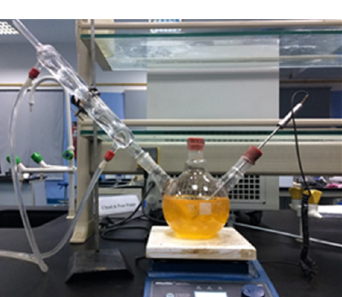
Figure 3. Experimental setup for biodiesel production. Figure 3 . Experimental setup for biodiesel production .